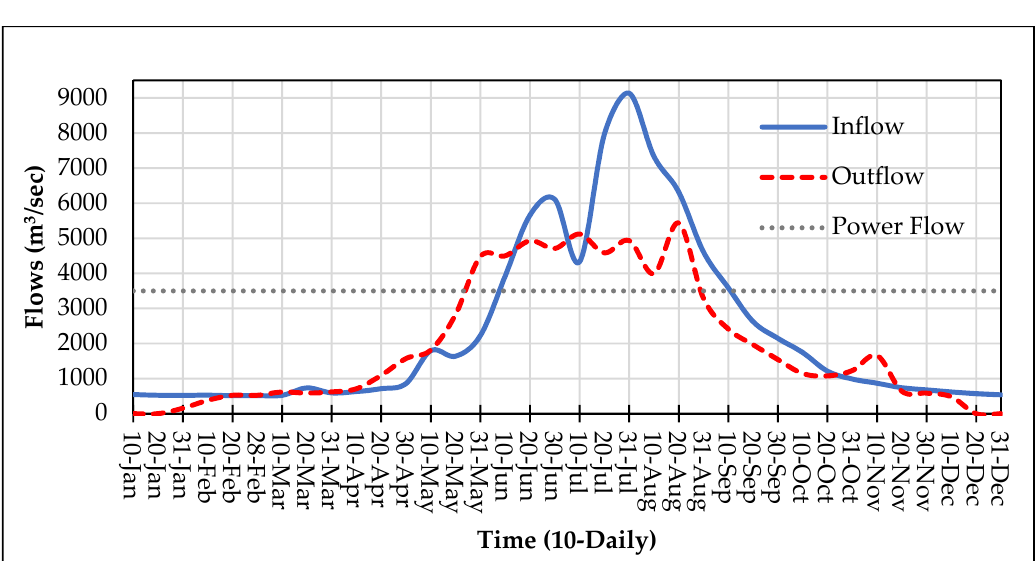
Figure 30. Inflow-Outflow Hydrograph of year 2012.